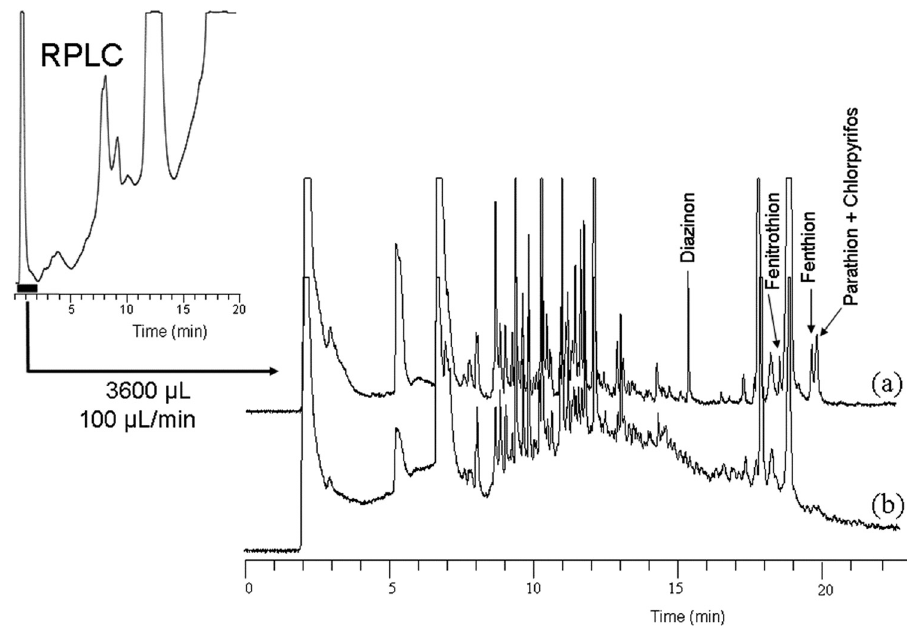
Figure 4: Liquid and gas chromatogram obtained from the online LC - GC - FID analysis of ( a ) an olive oil sampled spiked with a mixture of pesticides at 1 mg L − 1 and ( b ) an unforti fi ed olive oil sample. The thick line in the LC chromatogram indicates the LC fraction transferred from the liquid chromatograph to the gas chromatograph. Reprinted from ref. [ 51 ] with permission from Jennifer Diatz ( Director of Publications, AOAC International )